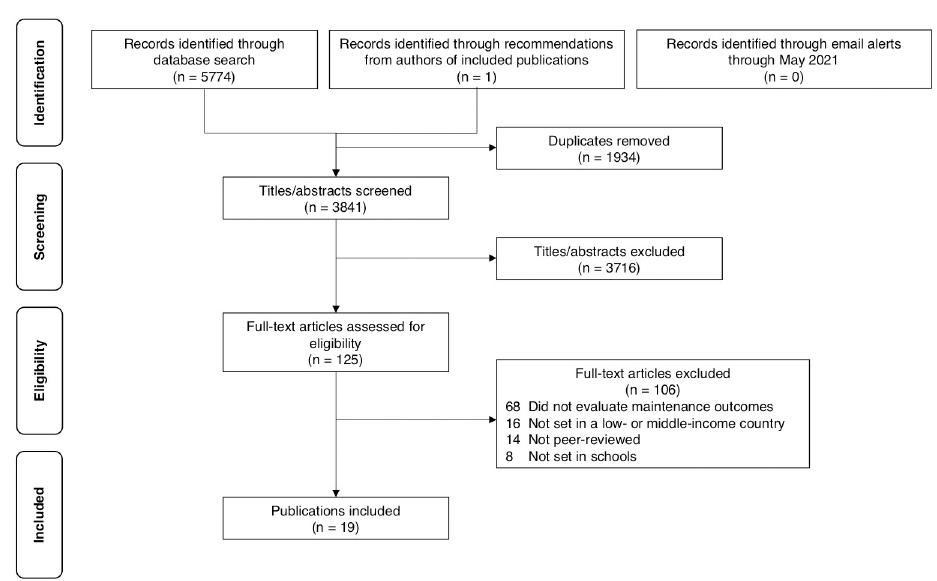
Fig 1. PRISMA flow diagram detailing the number of studies included and excluded at each screening